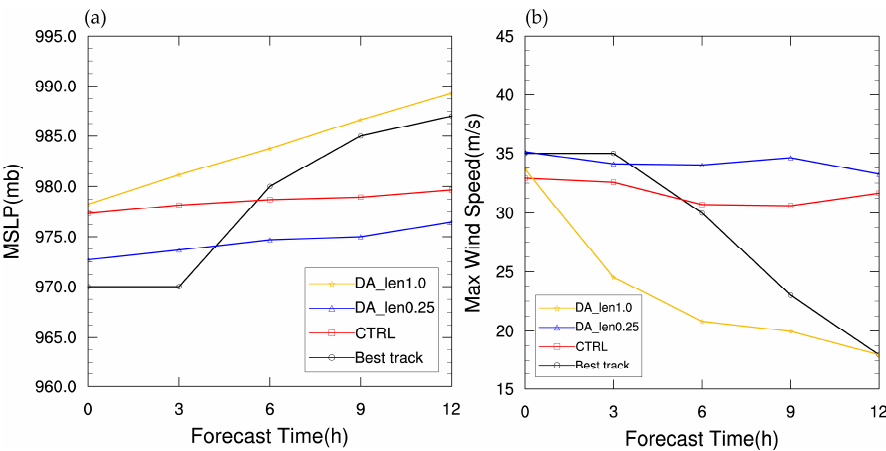
Figure 12. ( a ) Minimum sea-level pressure (unit: mb) and ( b ) maximum surface wind speed (unit: m s − 1 ) given by the three sets of experiments and the CMA observations.